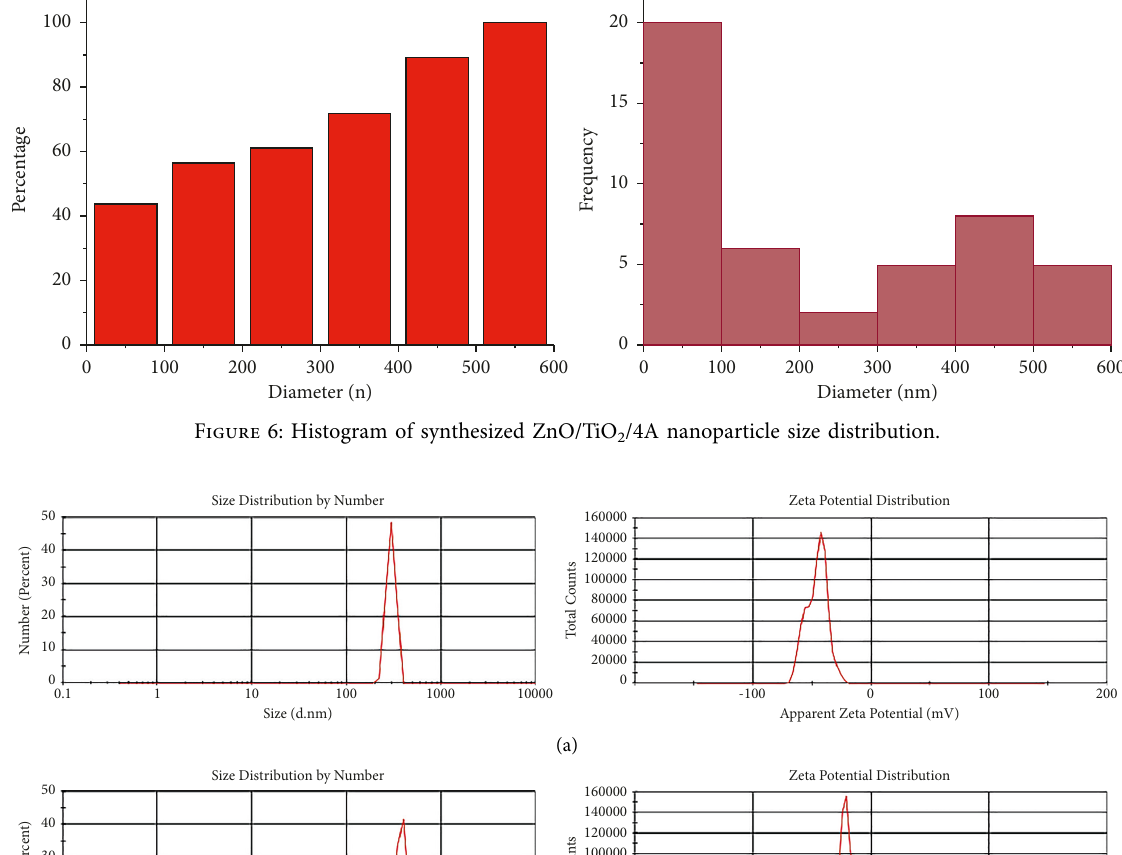
2 /4A nanoparticle size distribution.